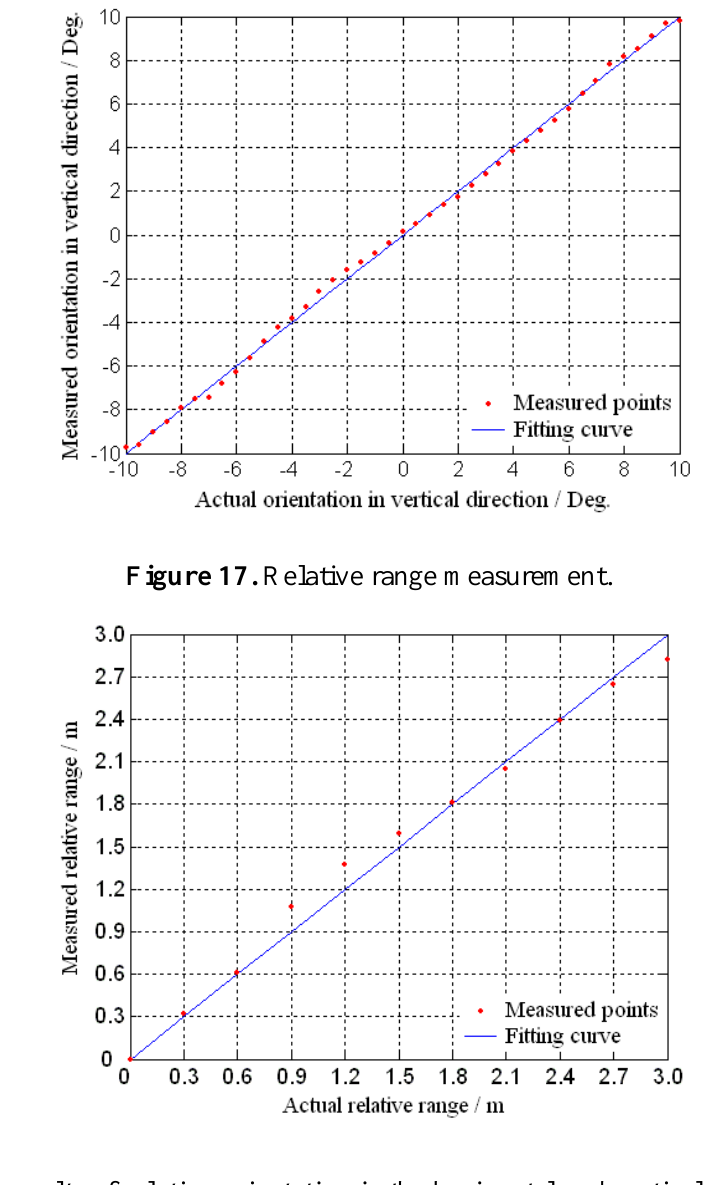
Figure 16. Orientation measurement in vertical direction.